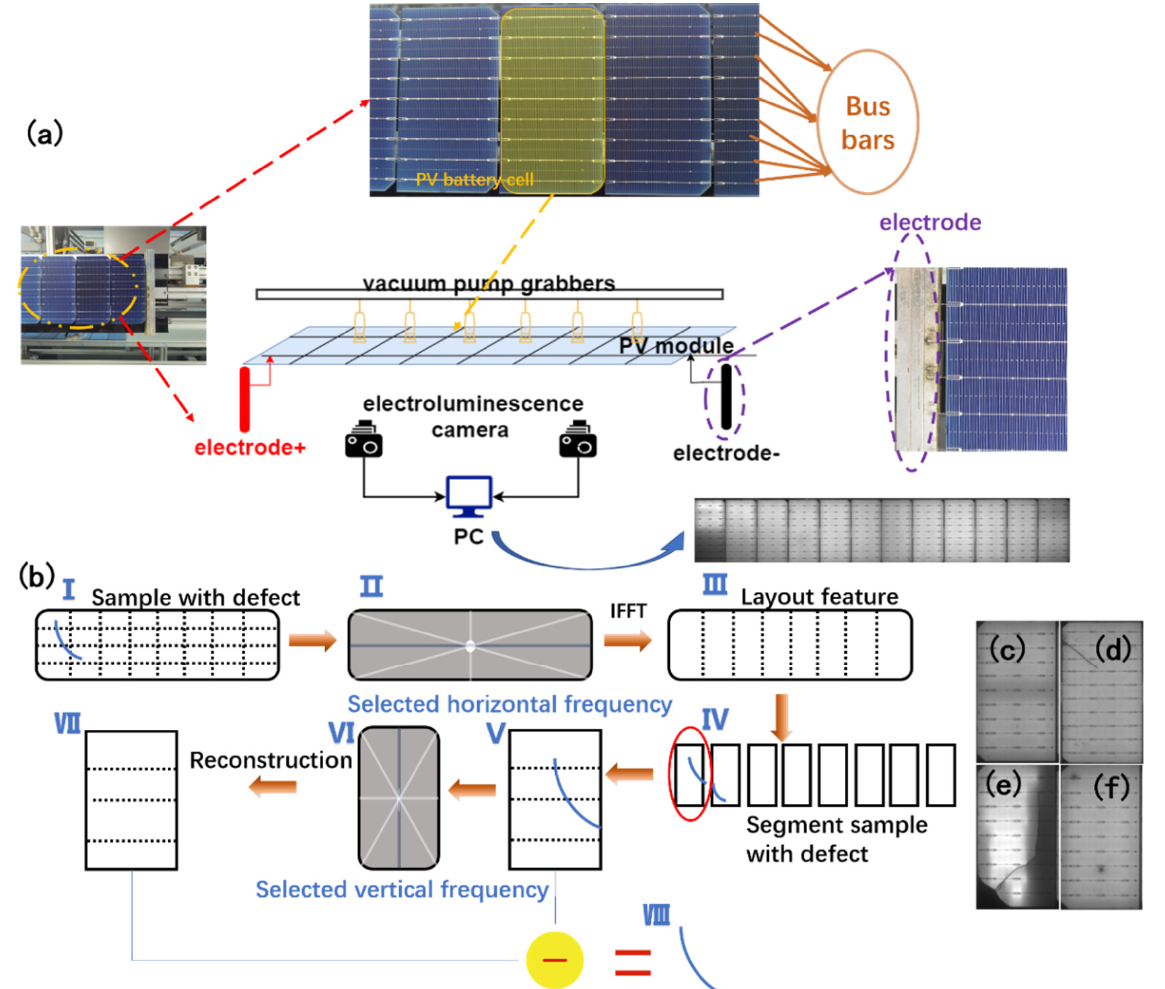
Figure 1. ( a ) The EL imaging system of a PV module inspection pipeline, which activates the EL effect on each module and converts infrared light into grayscale images; ( b ) the spectrum domain analysis-based method to exploit the periodic features and locate the defects; ( c ) normal PV cell in a defect-free module; ( d ) PV cell with cracks; ( e ) PV cell with cracks and breaks; ( f ) PV cell with speckles.